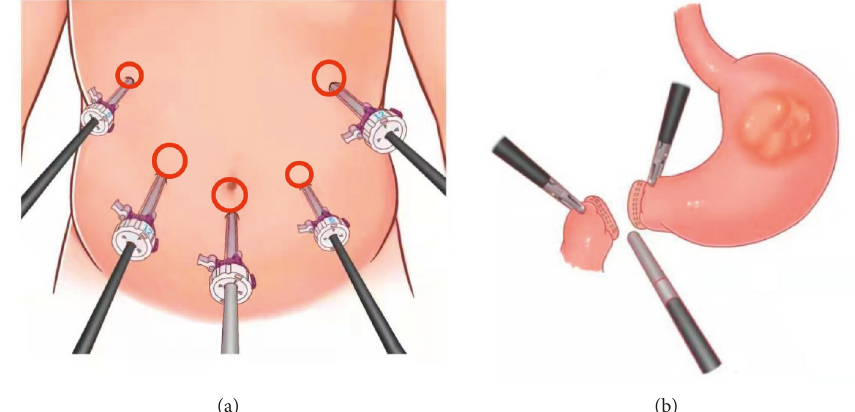
Figure 1: (a) Trocar hole position distribution, 1cm below the umbilical disposal into the 10 mm trocar as the observation hole. (b) The duodenum after